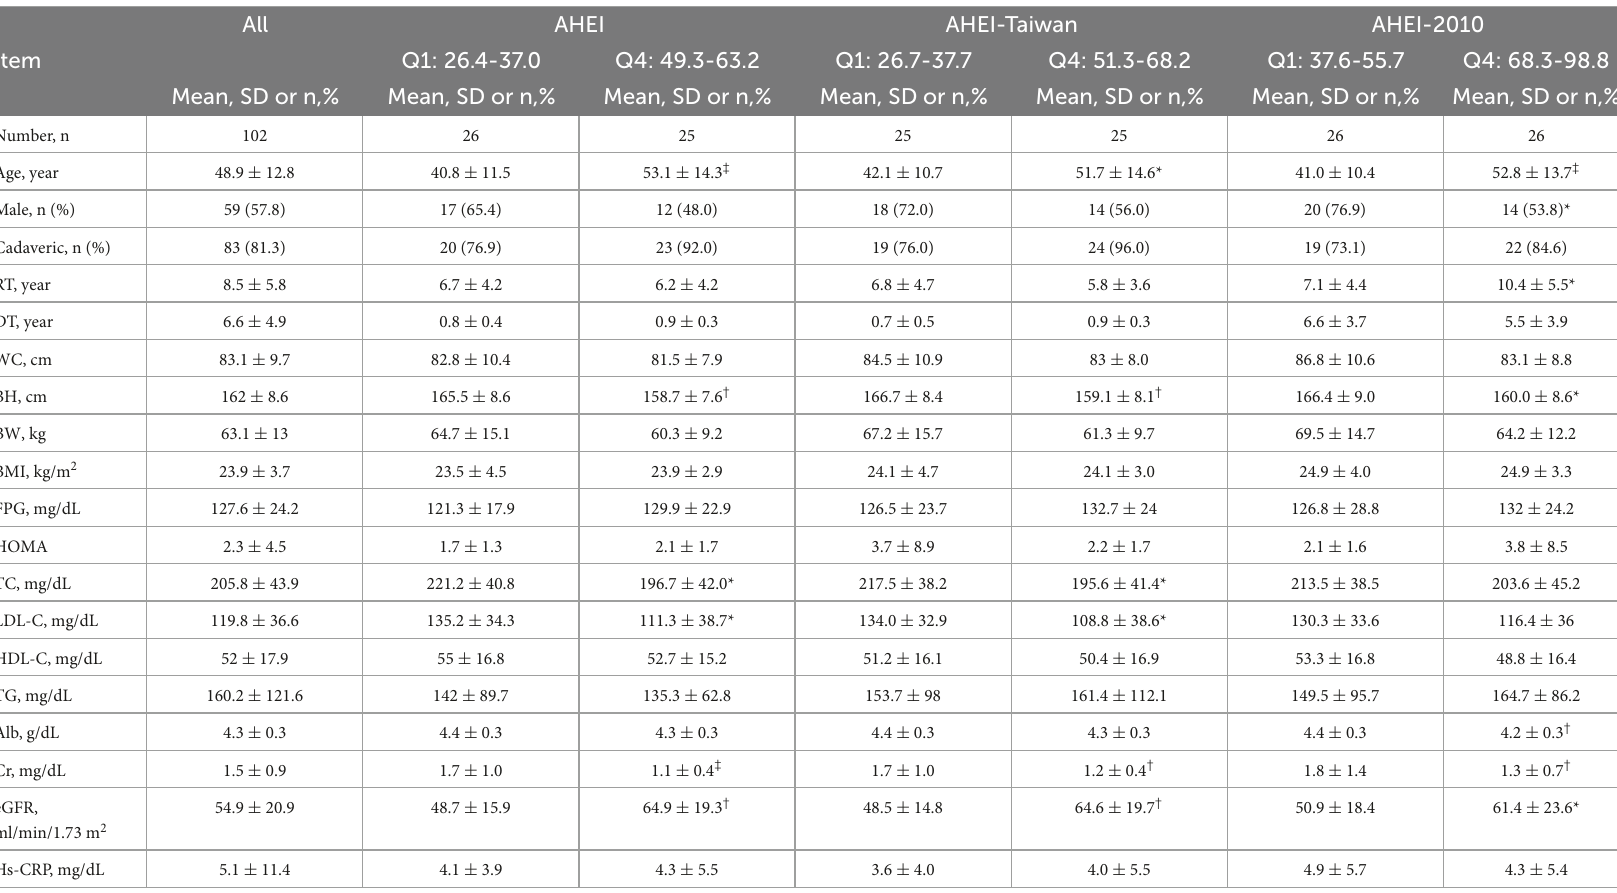
TABLE 1 Comparison of the components and scores of the AHEI and AHEI-Taiwan between the lowest and highest quartiles of dietary scores ( n = 102) 1 . All AHEI